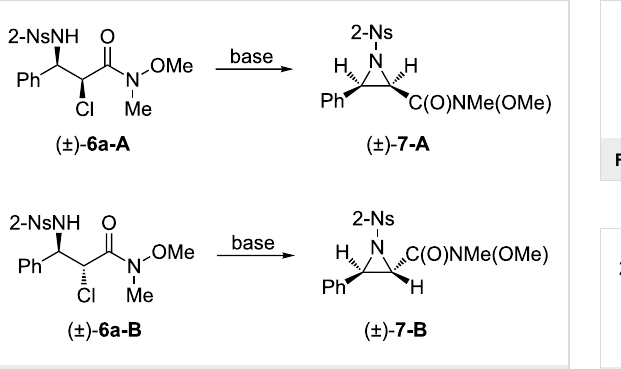
Scheme 3: Conversion of β -amino Weinreb amides to aziridines.